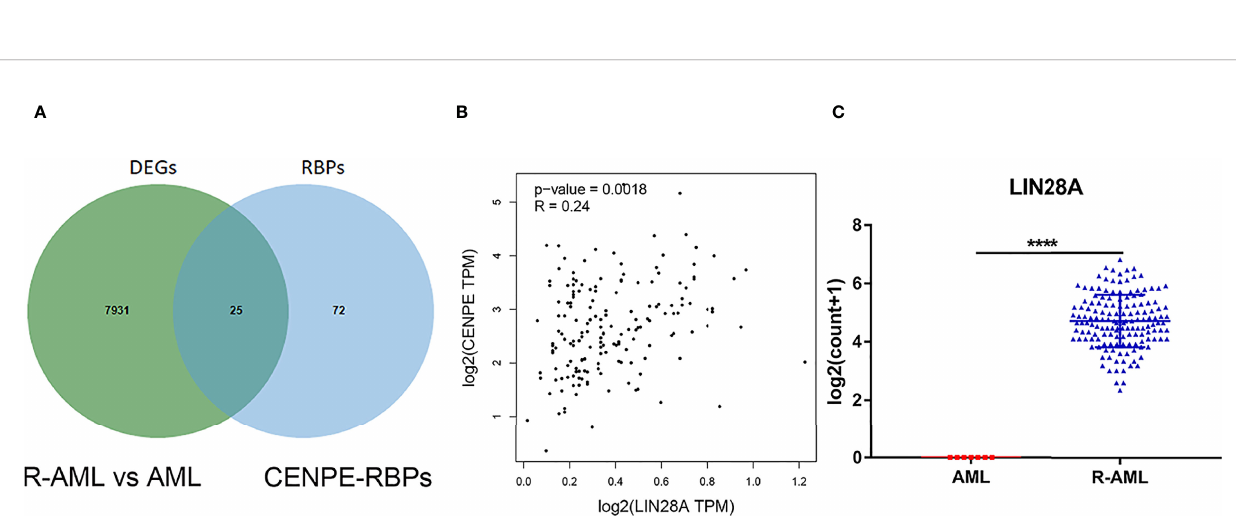
FIGURE 5 | CENPE expression was highly correlated with RBP LIN28A. (A) Starbase database was used to screen out 25 RBPs, which might bind to CENPE and were differentially expressed in R-AML. (B) CENPE expression was strongly related to RBP LIN28A ( r = 0.24; p < 0.05). (C) LIN28A gene expression were higher in the 151 R-AML whole blood samples from the TCGA database versus 7 primary AML samples from the GEO database. **** p <